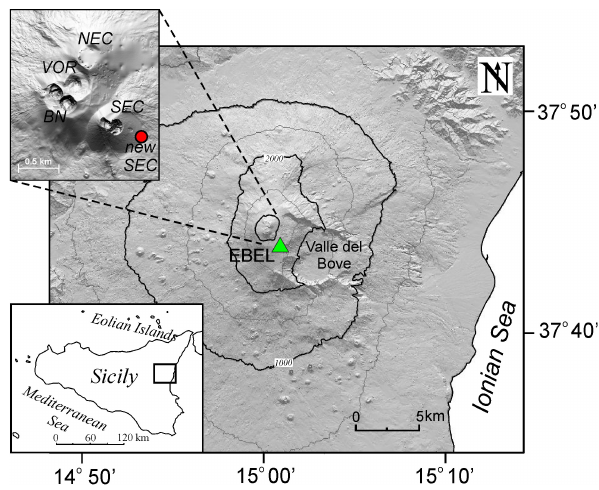
Fig. 1. Digital elevation map of Mt. Etna showing the location of EBEL infrasonic–seismic station (green triangle). The digital ele- vation model in the upper left corner shows the distribution of the summit craters (VOR: Voragine, BN: Bocca Nuova, SEC: south- east crater, NEC: north-east crater) and the new SEC, indicated by the red